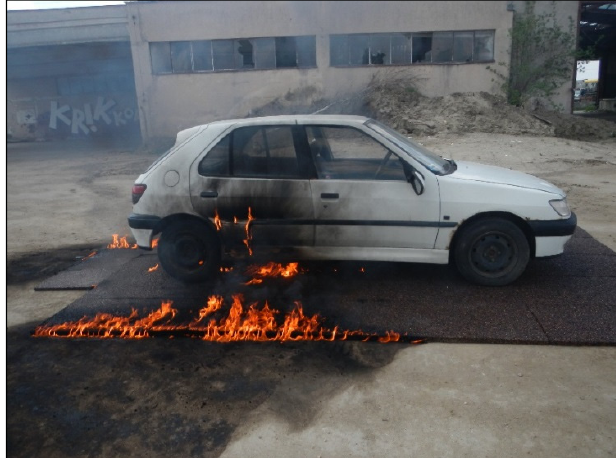
Figure 13. Car fire 260 s after ignition.